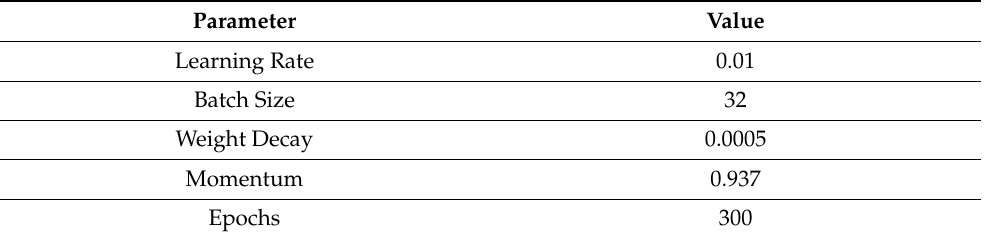
Table 2. Training